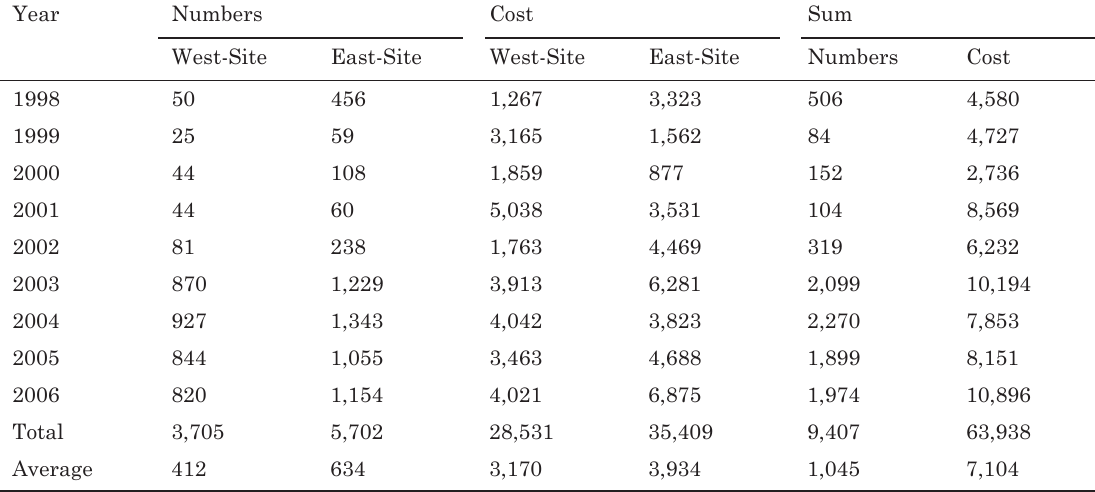
table 2. annual maintenance numbers and cost of